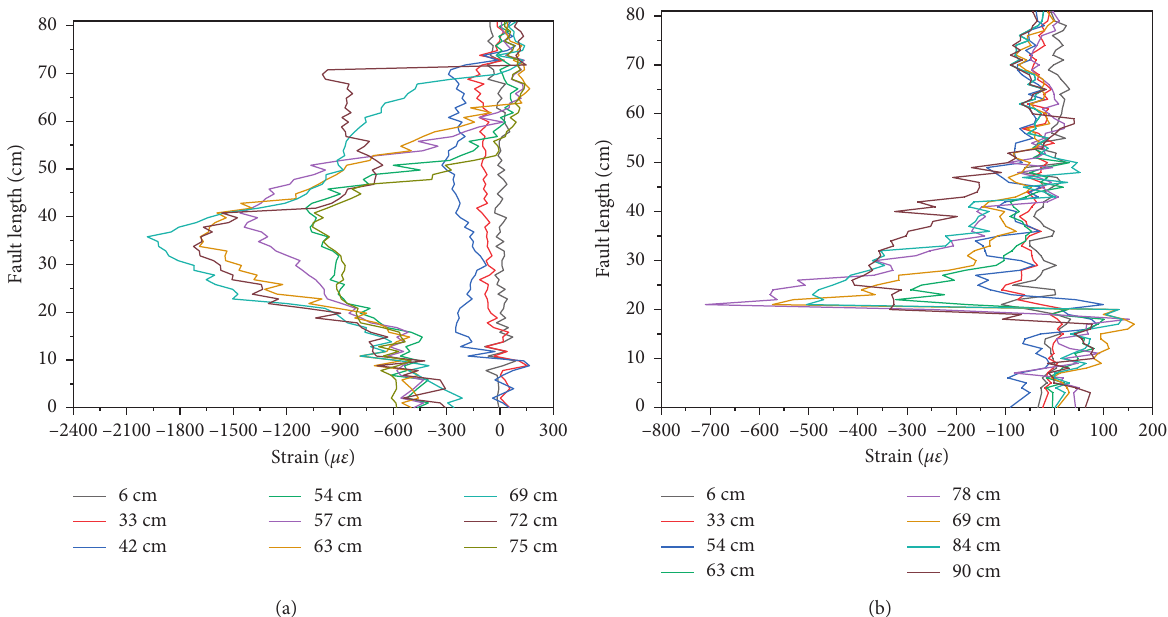
Figure 5: Fault plane strain fiber test results. (a) Fiber F11 of physical model I. (b) Fiber F21 of physical model II.